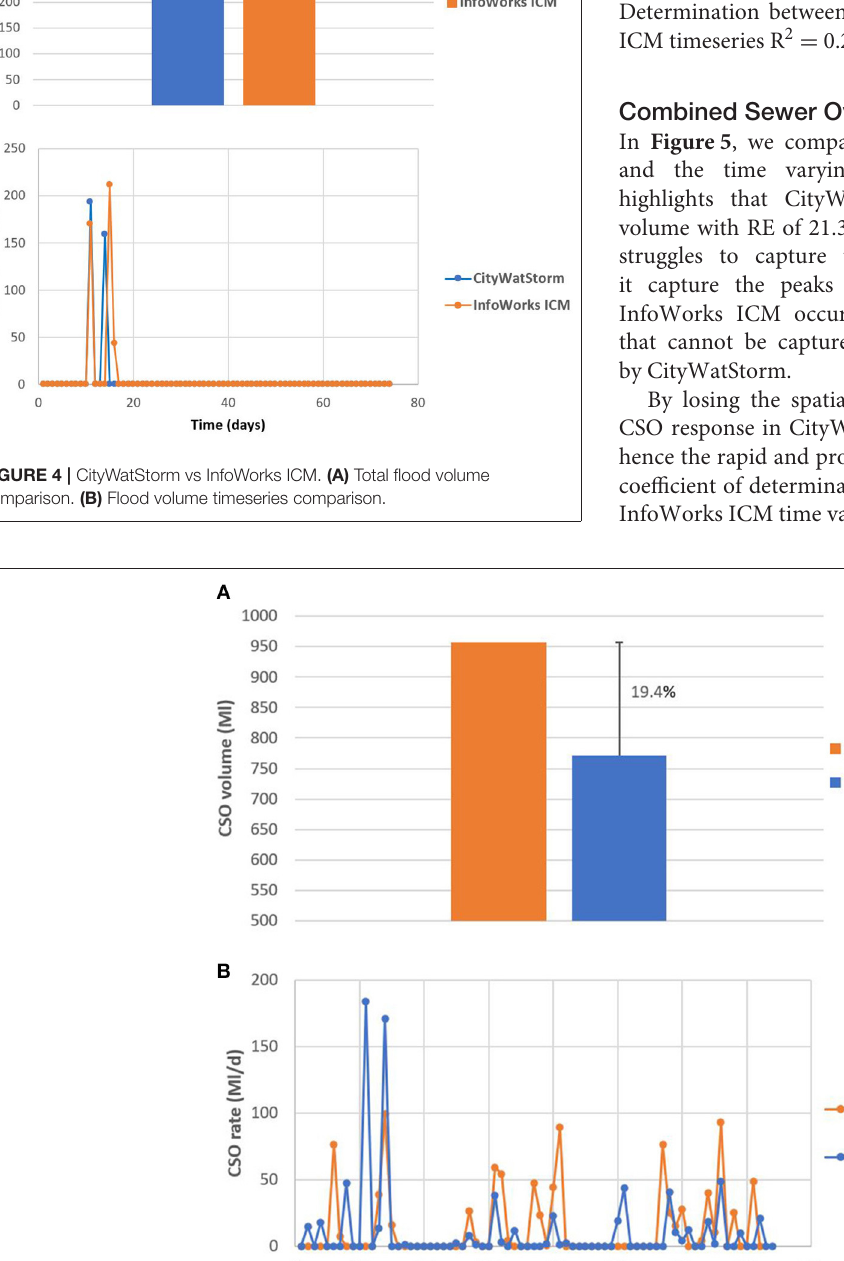
Frontiers in Water |